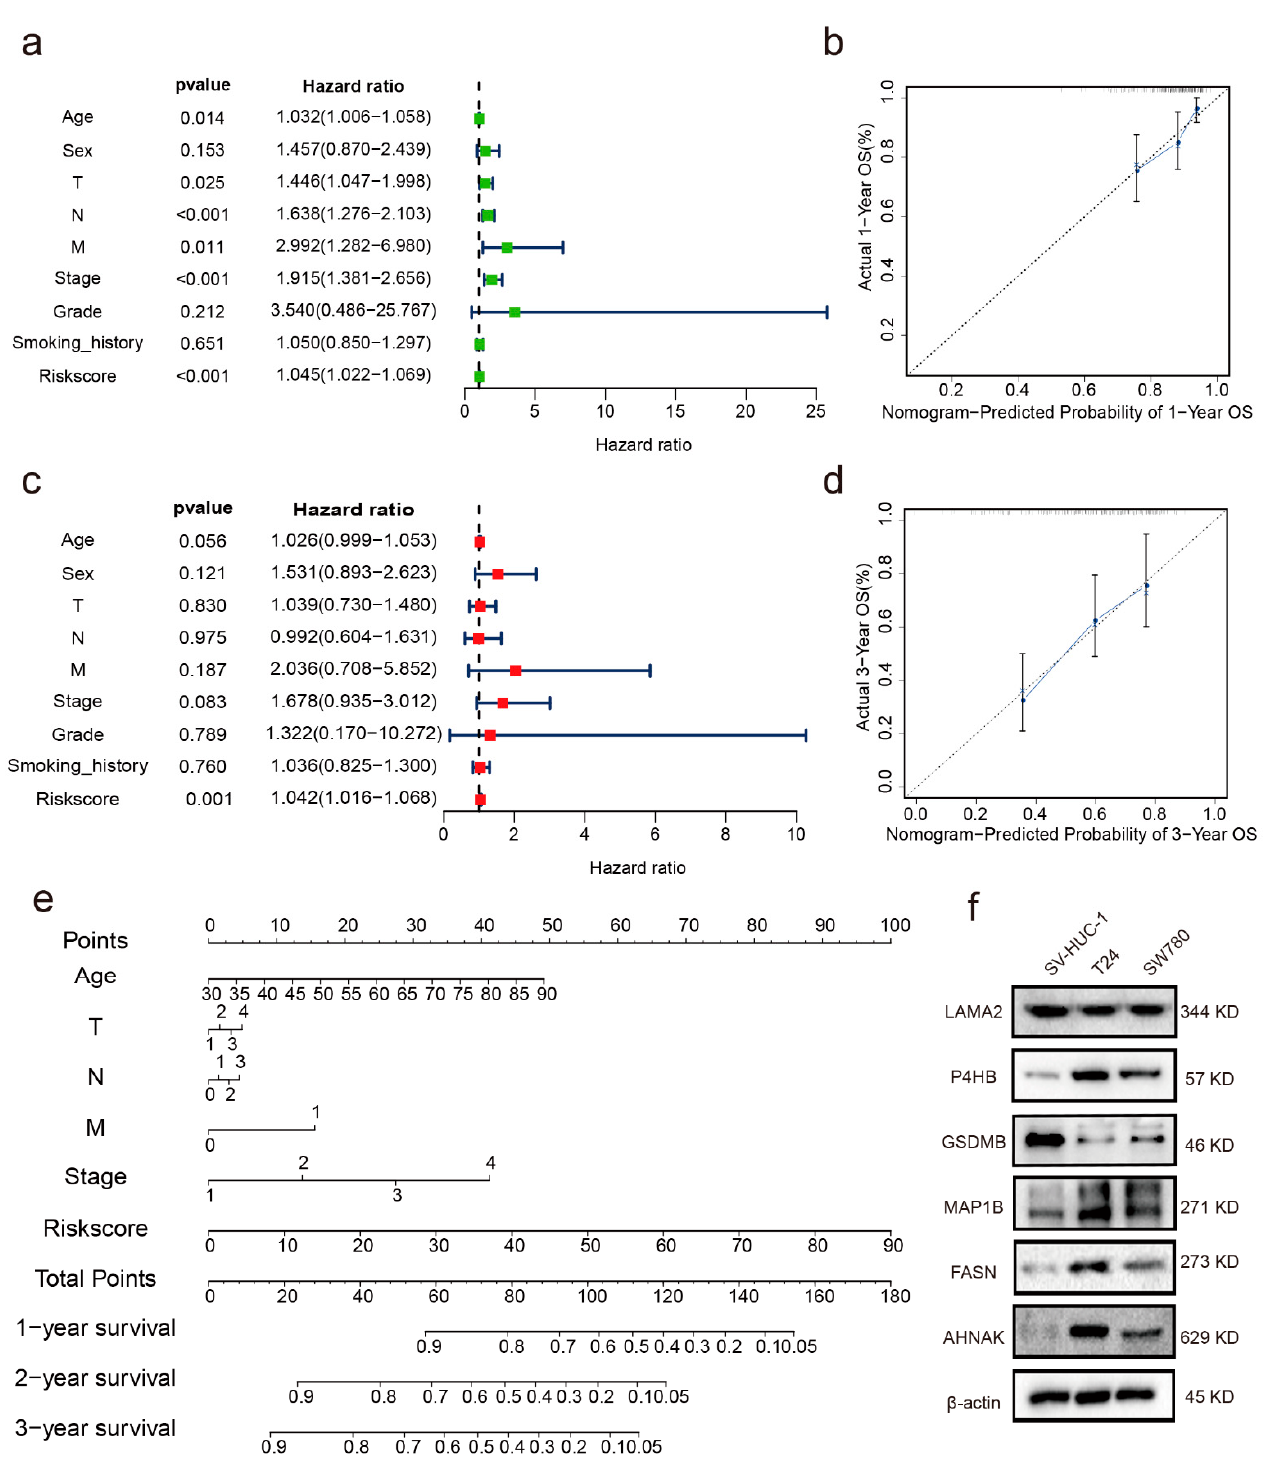
Figure 3. Independent prognostic analysis and prediction of 1- and 3-year nomograms for patients with BC in the training and validation cohorts. ( a ) Single-factor prognostic analysis for the training cohort. ( b ) Nomogram for the prediction of 1-year survival probability of patients with BC in the training set. ( c ) Multifactor prognosis analysis for the training cohort. ( d , e ) Nomograms for the prediction of 2- and 3-year survival probabilities for patients with BC in the training cohort. ( f ) Verification of protein expression levels of the six RBPs. The uncropped blots are shown in Supplementary Materials.